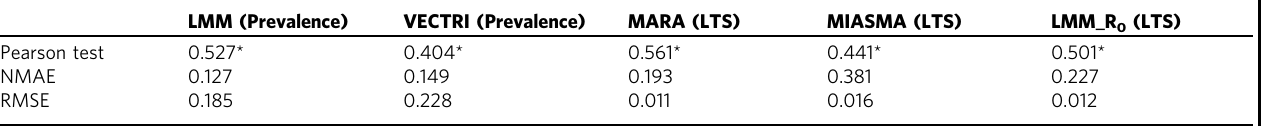
Table 1 Malaria models skill